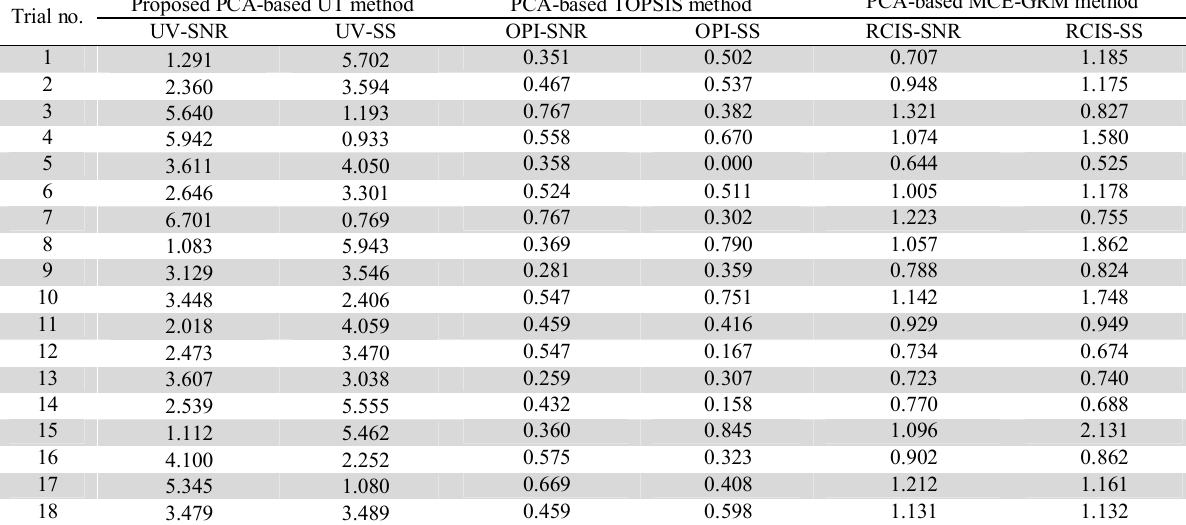
UV-SNR, UV-SS, OPI-SNR, OPI-SS, RCIS-SNR and RCIS-SS values (case study 2) Trial